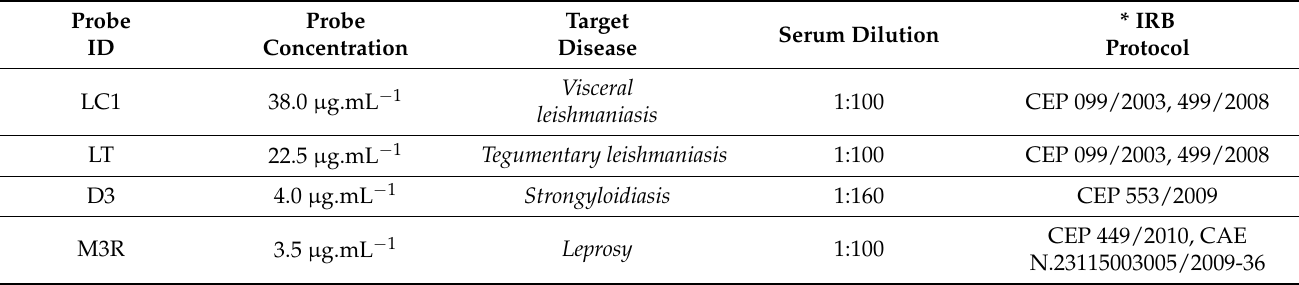
Table 1. Target diseases, probes ID and concentrations, serum dilution, and specific references for each